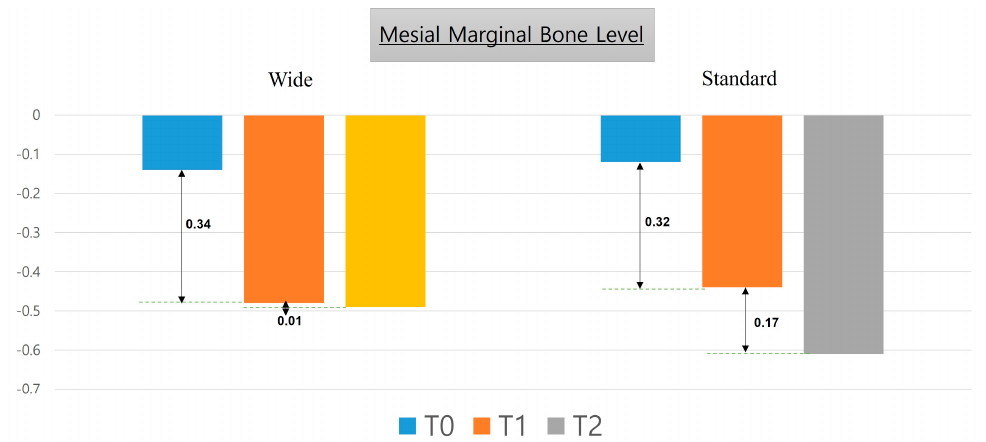
Figure 4. Changes in mesial marginal bone level six years after the placement of wide-diameter as well as standard-diameter implants.